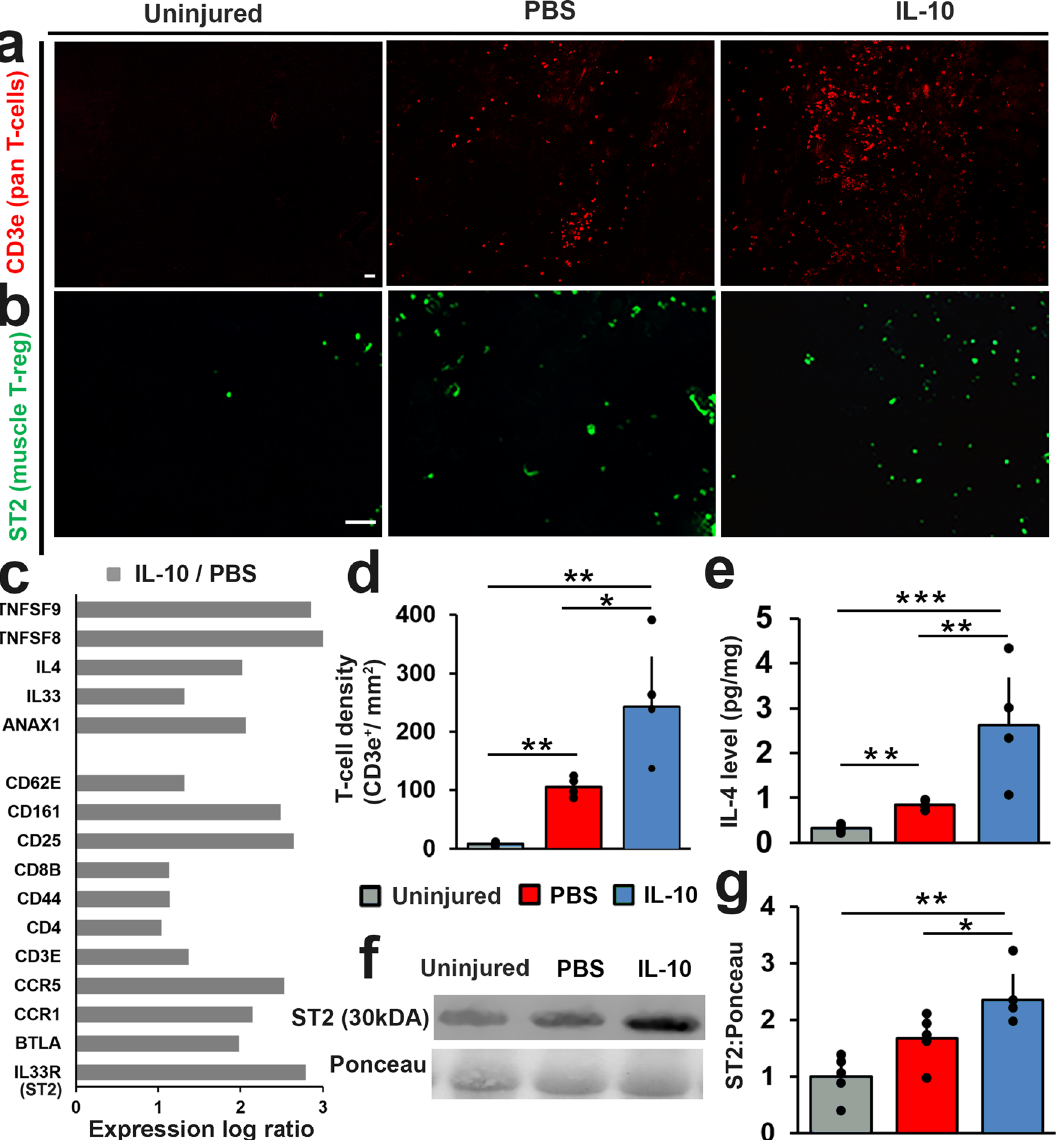
Figure 4. IL-10 delivery boosted the infiltration of pro-regenerative T-regulatory cells at the site of VML repair. TA muscle cross-sections were stained for ( a ) CD3e (red) and ( b ) ST2 (green). Representative TA cross- sections from uninjured, PBS, and IL-10 are presented. Scale bar = 100 µm. ( c ) Key differentially expressed (FDR < 0.05) T-cell related genes are presented as log ratio (log 2 FC) by comparing the transcriptome of IL-10 treatment to PBS controls. ( d ) CD3e immunostained tissue cross-sections were used to quantify T-cells density (CD3e + /mm 2 ). ( e ) IL-4 concentration (pg/mg) was determined from protein lysate using multiplexed ELISA. ( f ) Representative immunoblots stained with ST2 and Ponceau (original blot images shown in Fig. S3 ). ( g ) The relative (to Ponceau) ST2 protein contents for both IL-10 treatment and PBS controls were quantified from Western blots. ST2 protein concentration values were normalized to uninjured controls. Group means + SD are presented; n = 4–5/group. The *, **, and *** indicate statistically significant difference of p < 0.05, p < 0.01, and p < 0.001 between